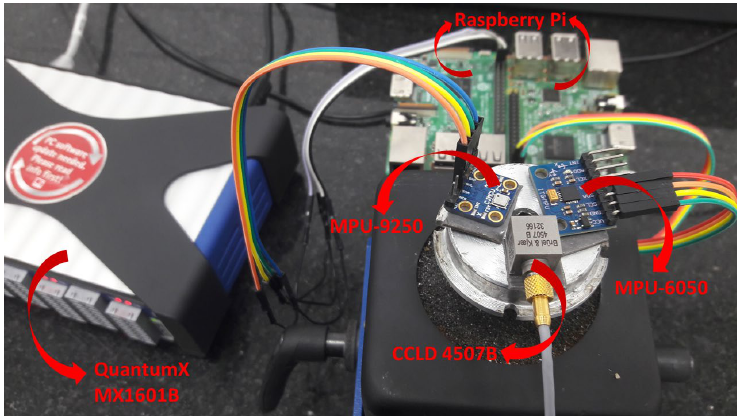
Figure 4. Testing setup (three accelerometers attached to the shaker).